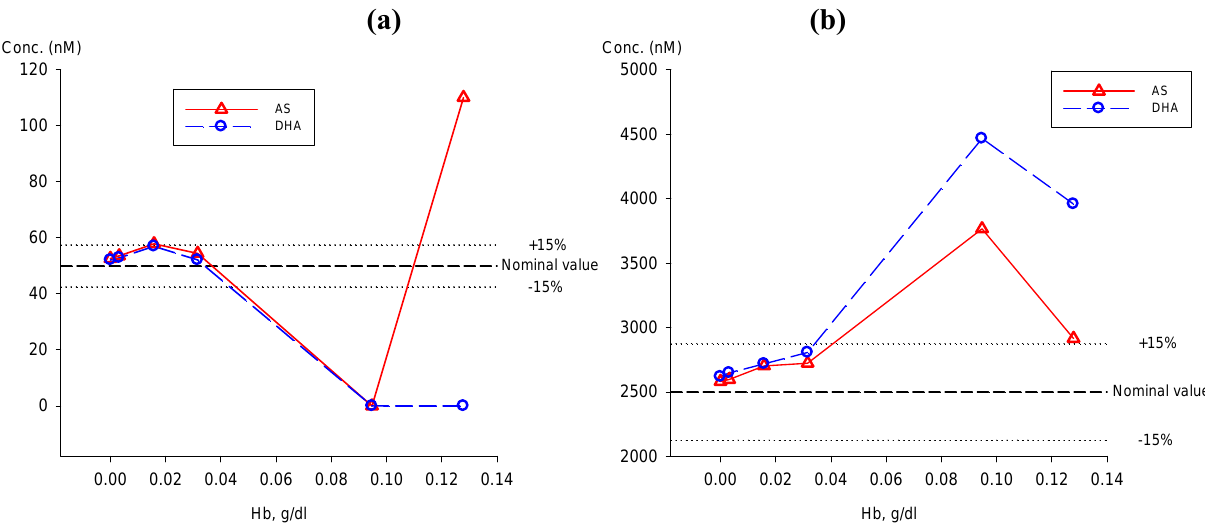
Figure 9. Effect of haemoglobin (Hb) from haemolyzed blood in plasma on the measurement of AS ( Δ ) and DHA ( o ) at ( a ) 50 nM and ( b ) 2,500 nM.